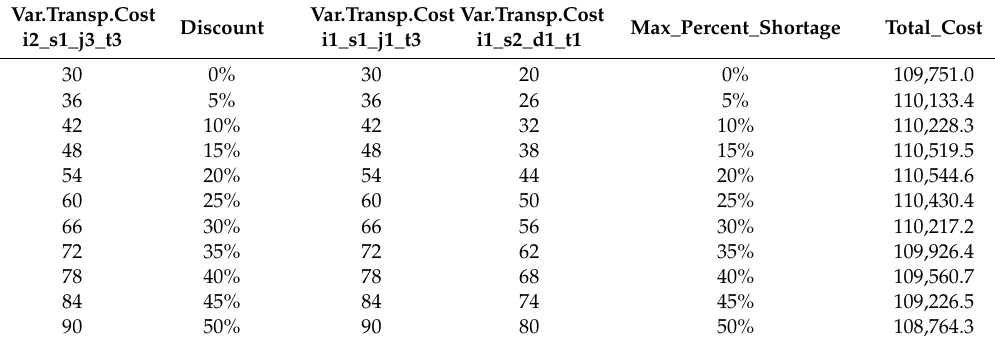
Table 5. Multiple optimization analysis report of varying selected parameters simultaneously for 11